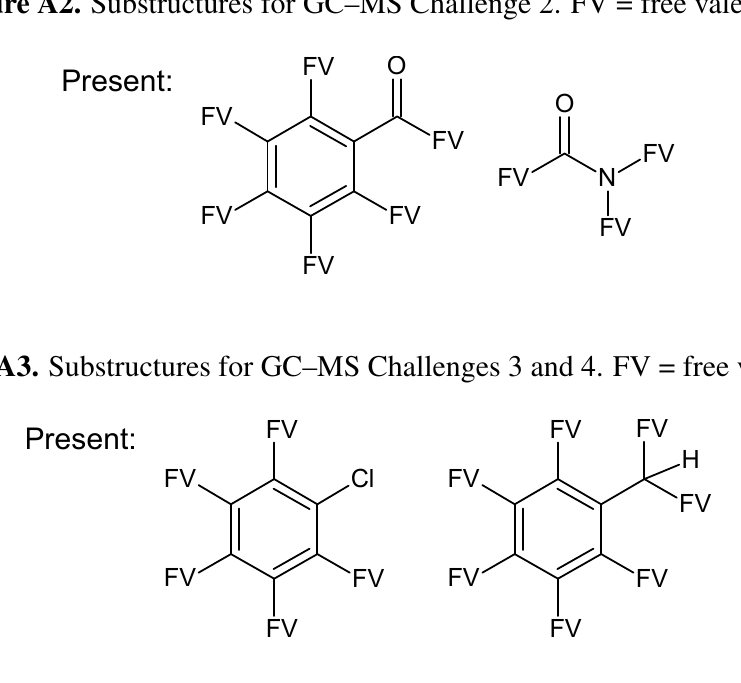
Figure A2. Substructures for GC–MS Challenge 2. FV = free valence.